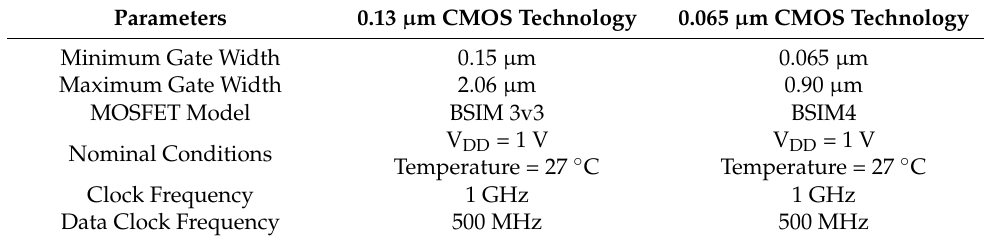
Table 2. CMOS simulation parameters.